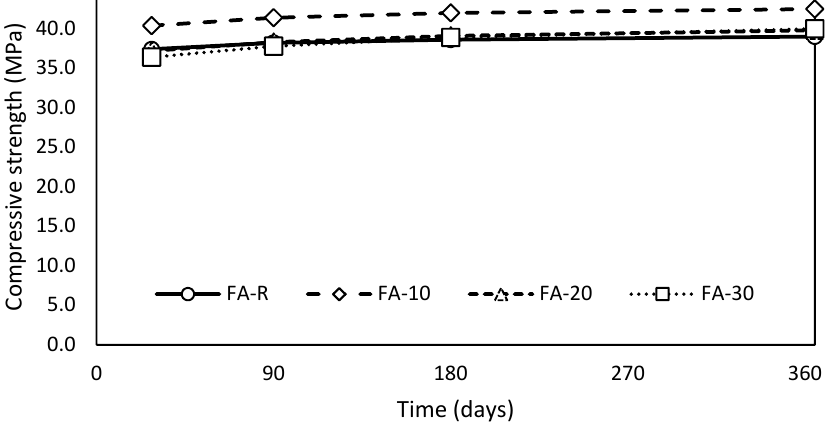
Figure 5. Evolution of compressive strength in time.